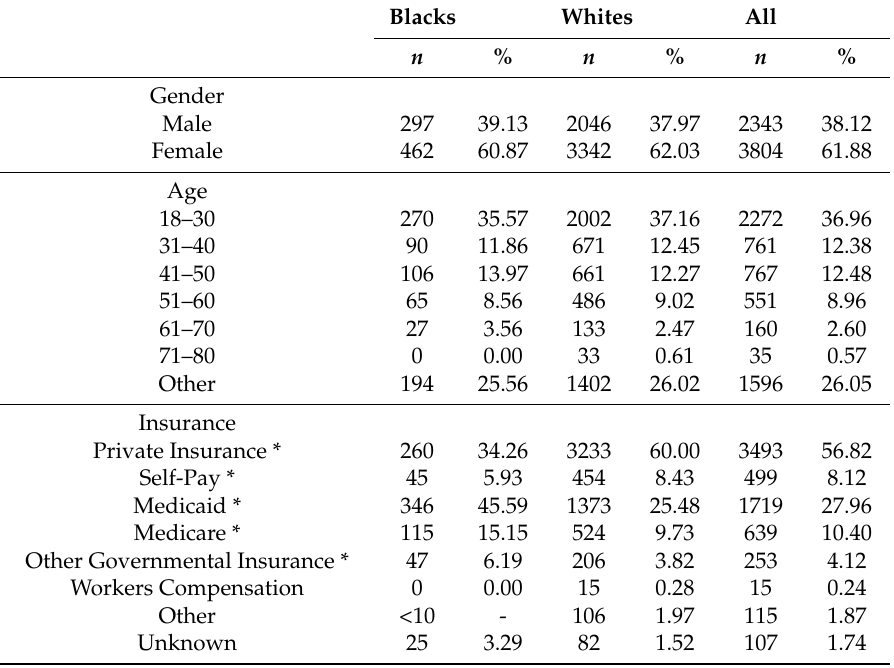
Table 1. Demographic and insurance characteristics for Blacks ( n = 759) and Whites ( n = 5388) with suicidal attempt.